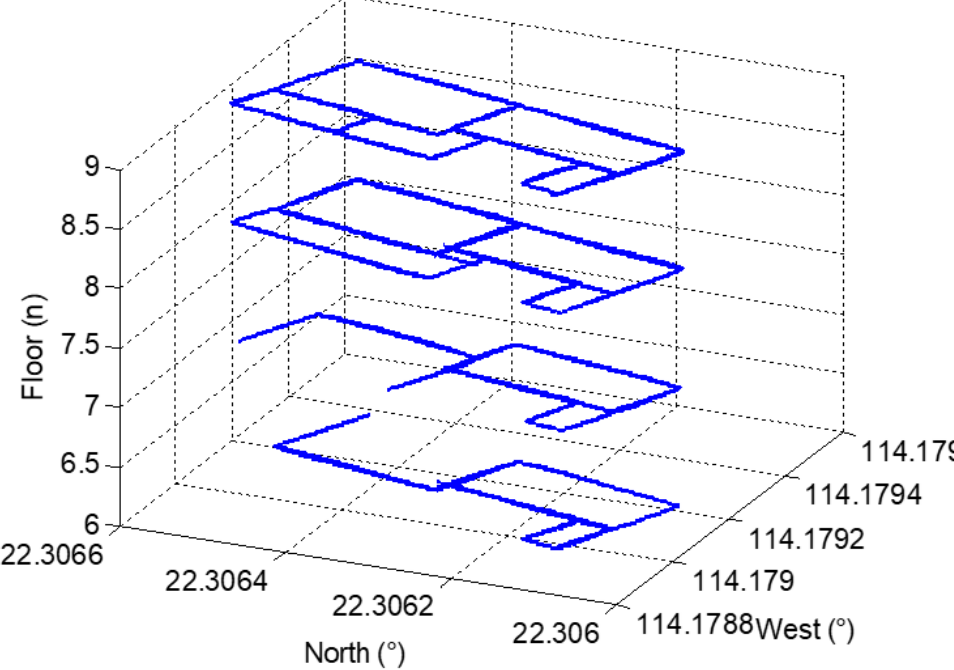
Figure 11. Reconstructed 3D Indoor